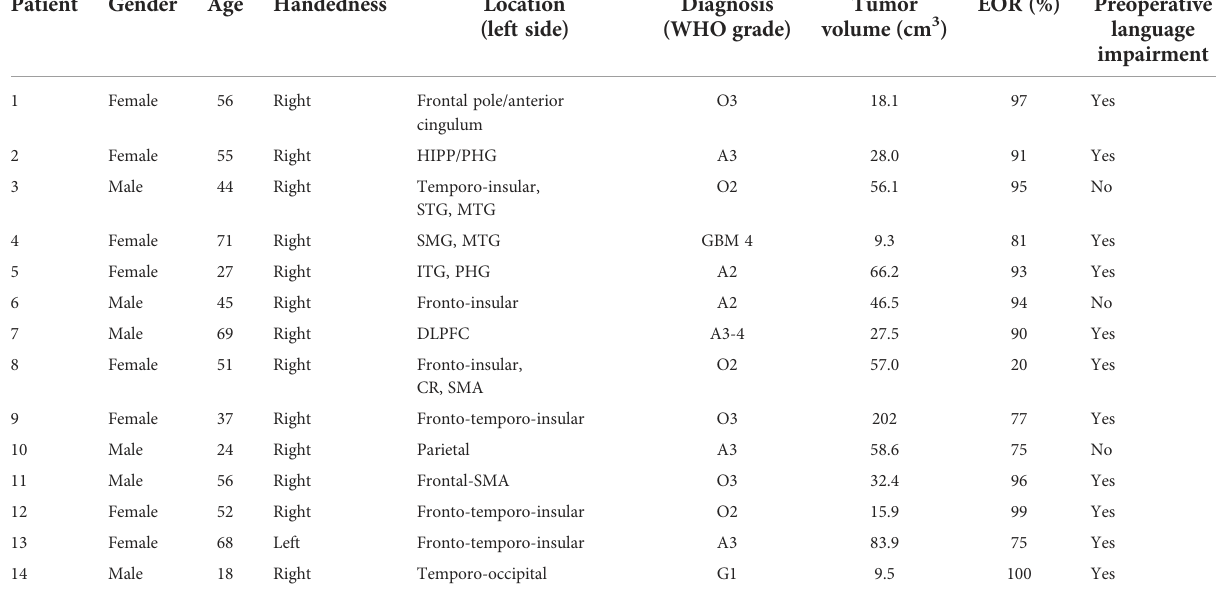
TABLE 1 Patient